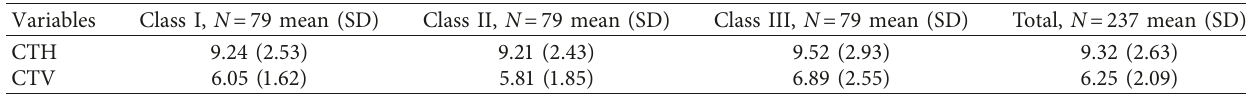
Table 3: Mean values of chin variables among different skeletal malocclusion groups.